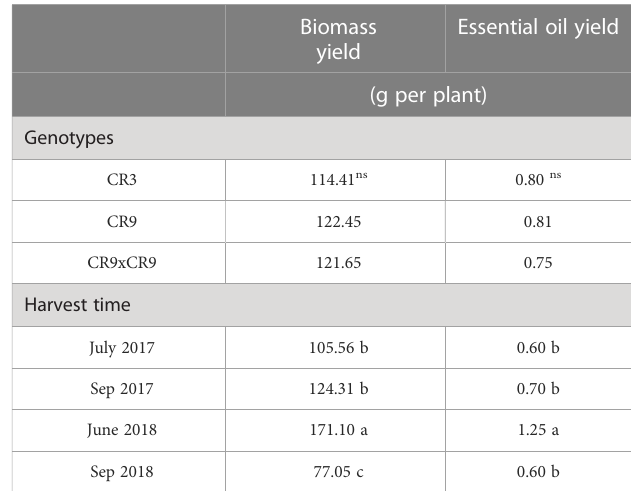
TABLE 2 Main effect of genotype and harvest time on biomass yield and essential oil yield of novel catnip